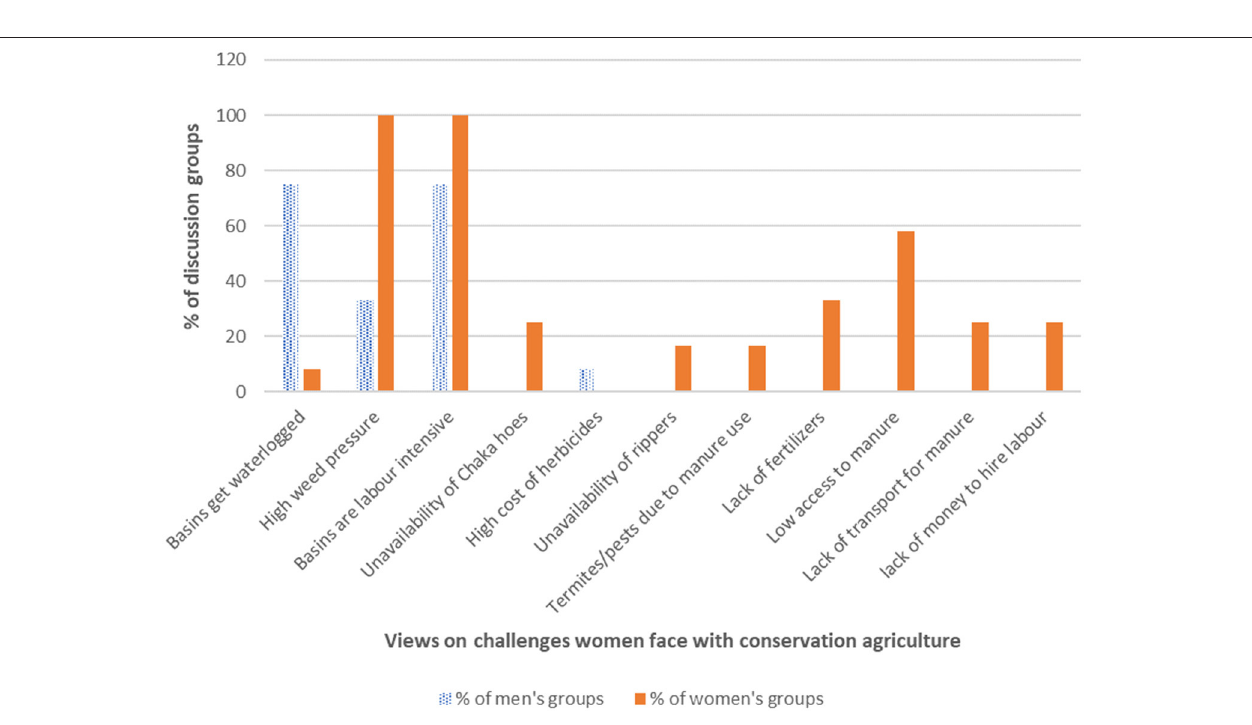
FIGURE 11 | Views on challenges of conservation agriculture for women.